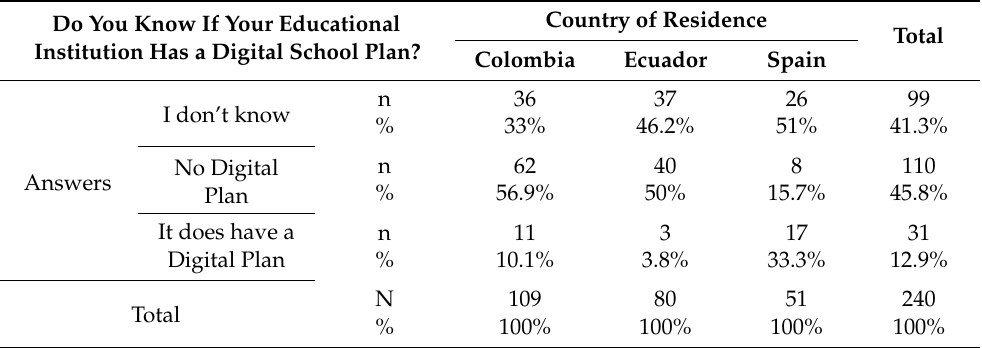
Table 14. Cross-categorization of the variable “Do you know if your educational institution has a Digital School Plan?” and the variable “Country of